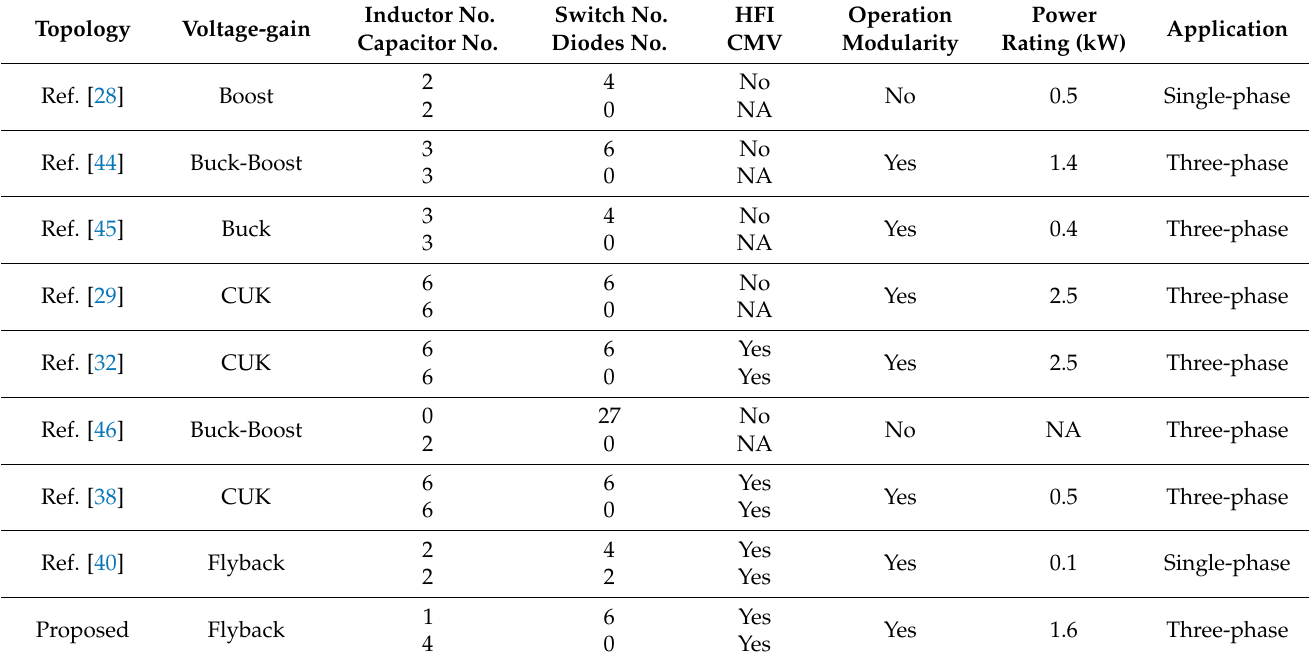
Table 1. Comparison of IFBI with recent inverter structures.